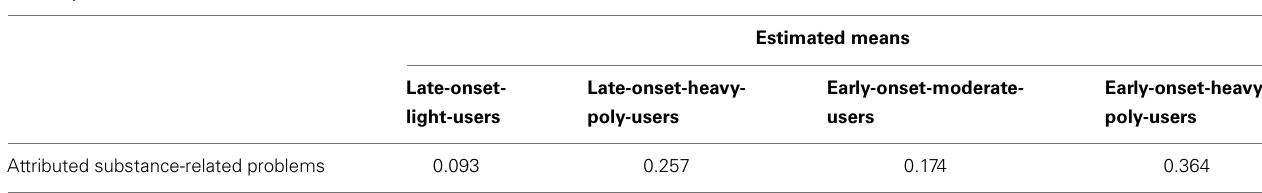
Table 4 |Adjusted outcomes at age 16 of substance-use